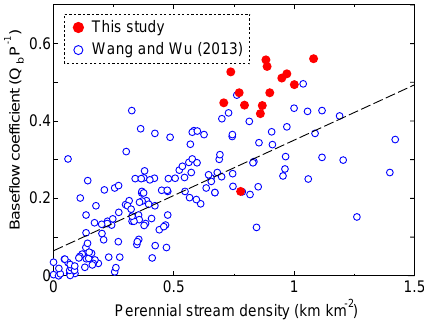
Figure 14. Relation between baseflow index and aridity index in Japan and MOPEX (Model Parameter Estimation Experiment) catchments in the US aridity index does not explain variability in baseflow index.